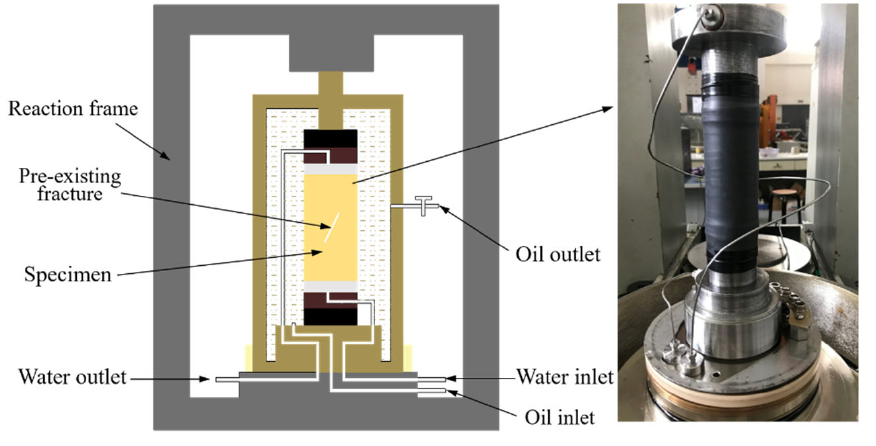
Figure 5. Pressure chamber structure.